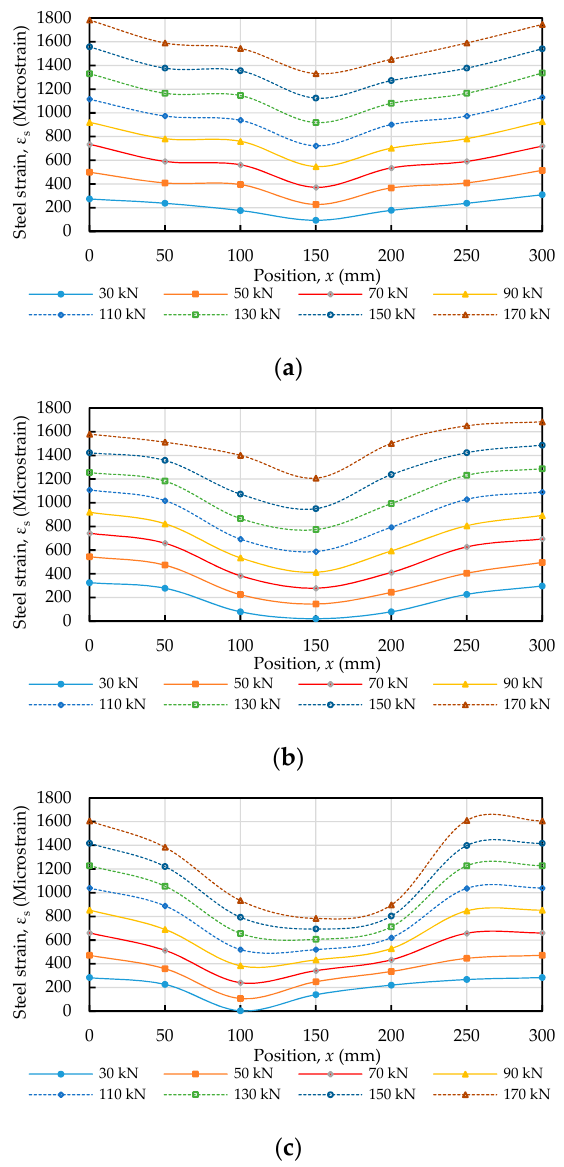
Figure 8. Strain distribution in steels bar subjected to tensile load: ( a ) C20, ( b ) C40, and ( c ) C60.